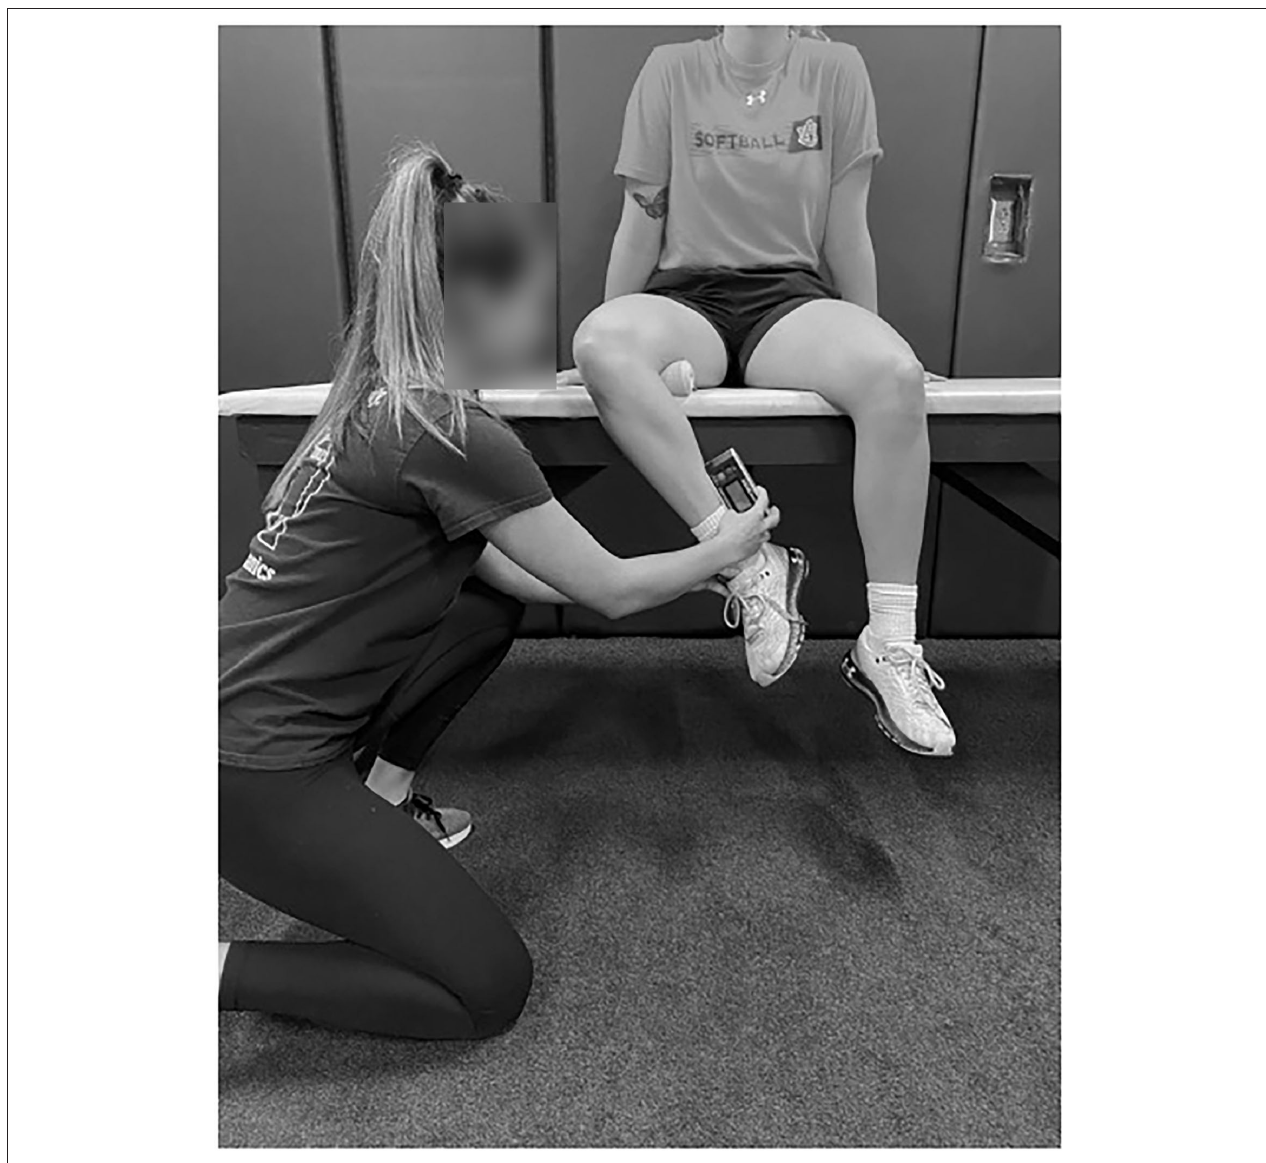
FIGURE 2 | Hip ER ROM